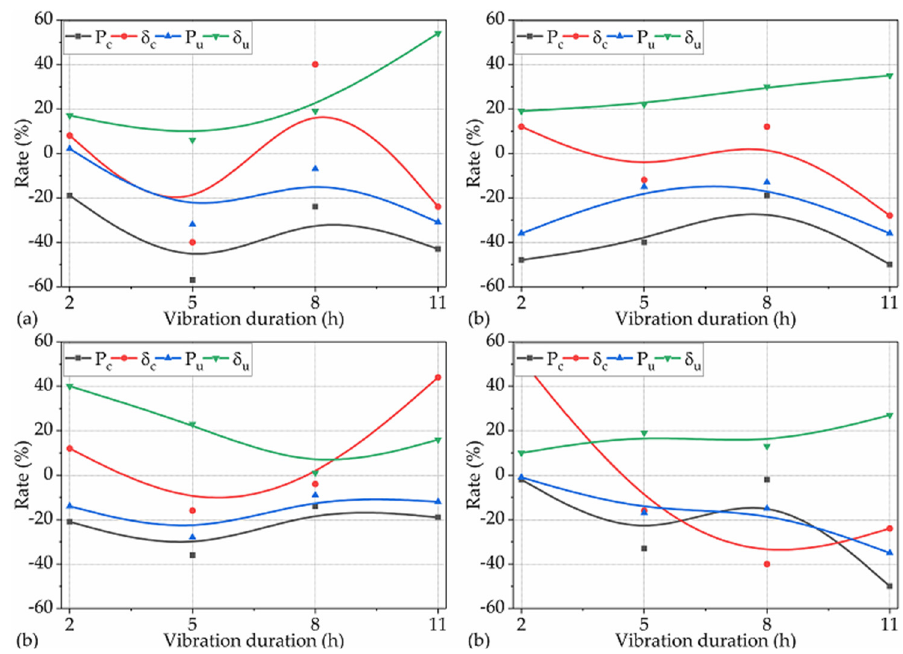
Figure 8. Rates of the P c , δ c , P u , and δ u of the 16 groups of specimens over the corresponding control averages under the operating conditions for Var. 2 with frequencies of ( a ) 2 Hz, ( b ) 3 Hz, ( c ) 4 Hz, and ( d ) 5 Hz.